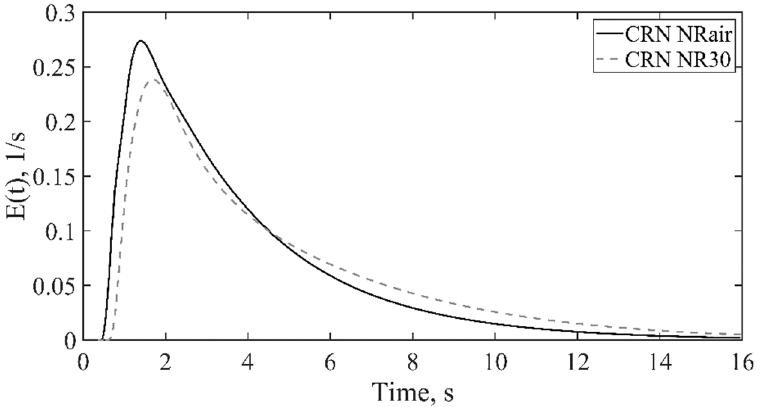
Figure 6. Comparison between the CRN-fit for NRair and